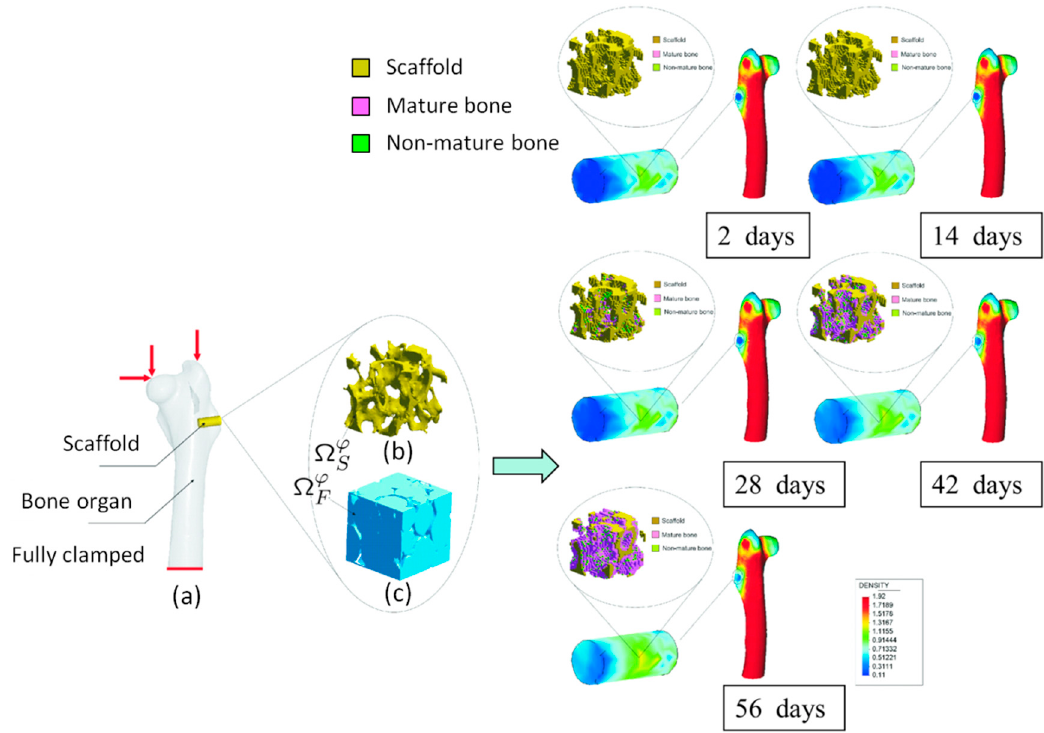
Figure 16. Multiscale and multiphysics bone tissue regeneration using biodegradable scaffolds. ( a ) Proximal femur implanted with a scaffold in the greater trochanter region. A detail of the microstructure is shown in ( b ) solid domain and ( c ) fluid domain. Right: Apparent (macroscopic) density evolution (g cm − 3 ) of the bone organ and detail of the scaffold implantation. Microscopically, bone regeneration distribution onto the scaffold microsurface of the macroscopic scaffold midpoint is shown for different days after implantation. See [24].